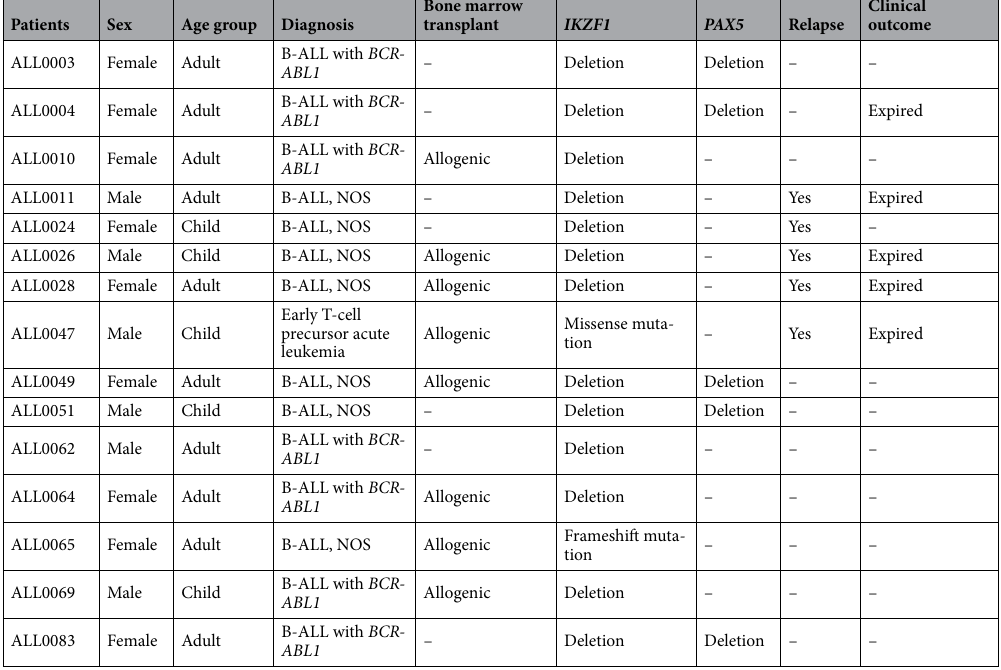
Table 3. IKZF1 alteration cases.